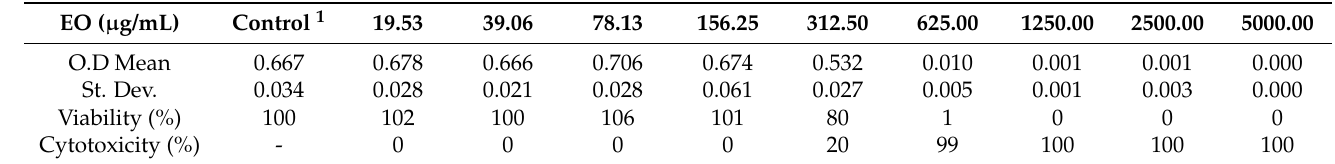
Table 4. Cytotoxic determination of EO on HaCaT keratinocytes (24 h incubation time, broad EO concentration range).